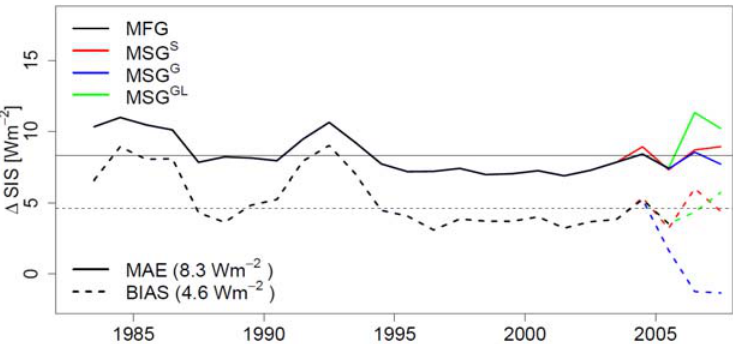
Figure 4. Mean annual bias (dashed line) and MAE (solid line) in absolute values from 1983 to 2007 obtained between the CM SAF and the GEBA series over